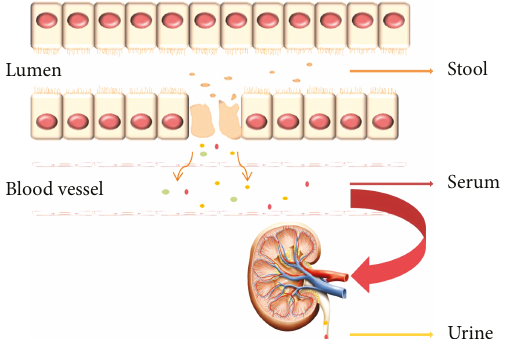
Figure 1: Source of the noninvasive biomarker for NEC. When intestinal epithelial cells are damaged, some cell component can be detached, mixed with the feces, and then excreted. Some proteins or cytokines are released into the bloodstream and then excreted by the